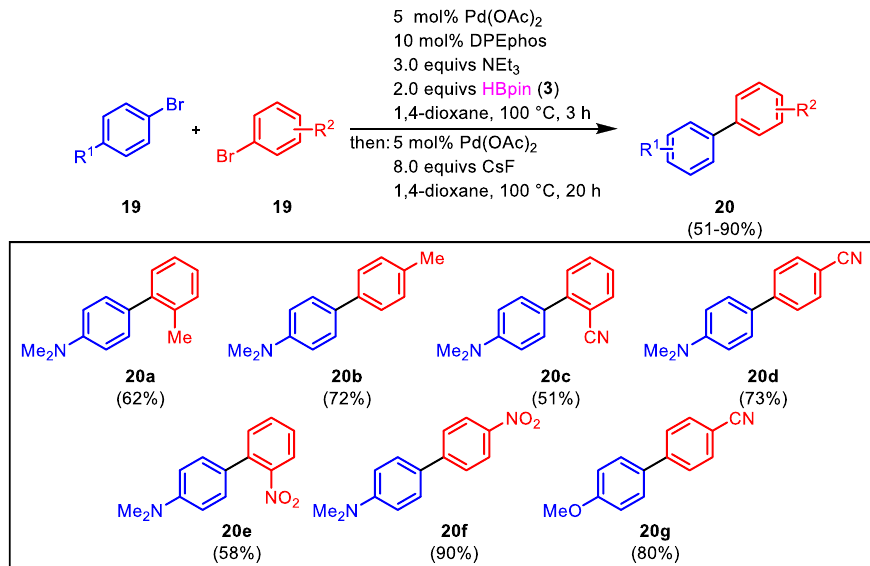
Figure 13. Synthesis of unsymmetrically substituted biaryls 20 via one-pot MBSC sequence by Colobert [41].